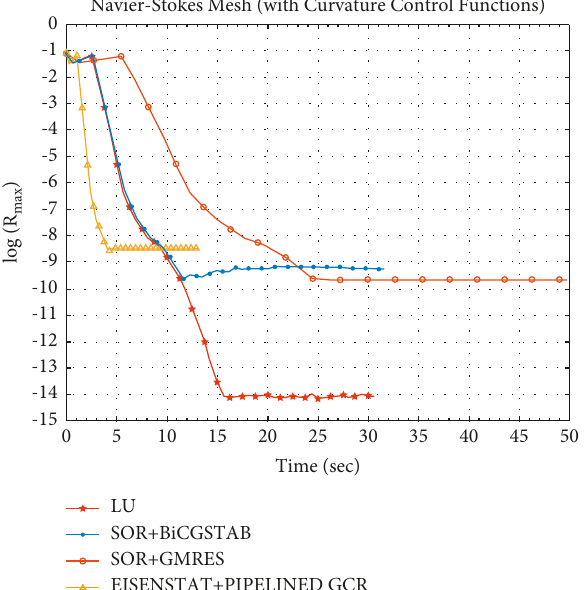
Figure 20: Convergence rates vs. time, with and without curvature functions.